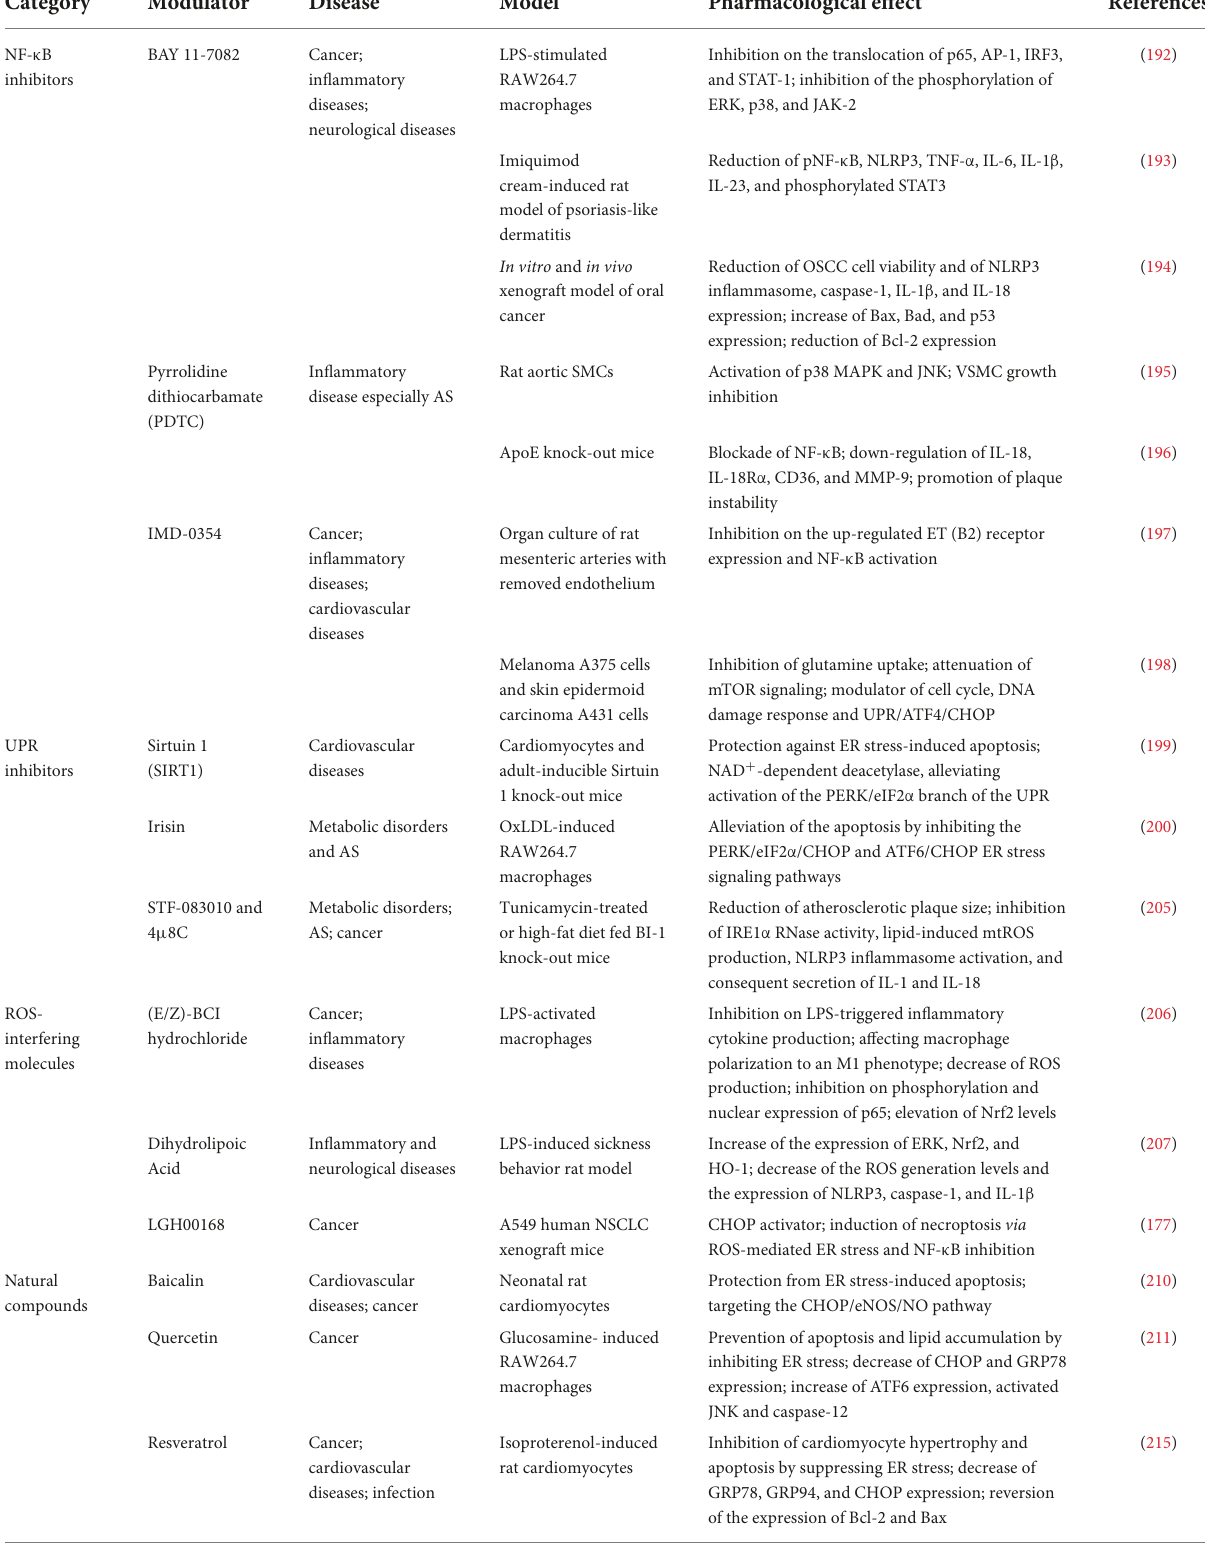
TABLE 3 NF- κ B and/or ER stress modulators in experimental atherosclerosis and associated disease